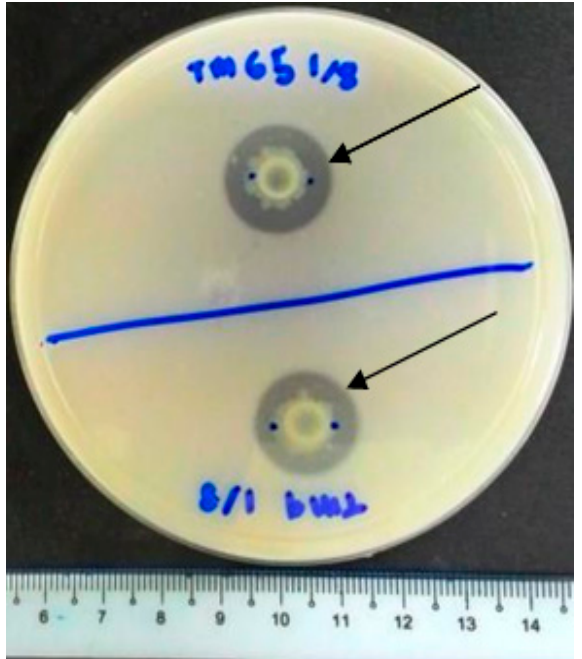
Figure 2. Zn solubilization by bacterial isolates showing halo zone formation on mineral salts agar medium.